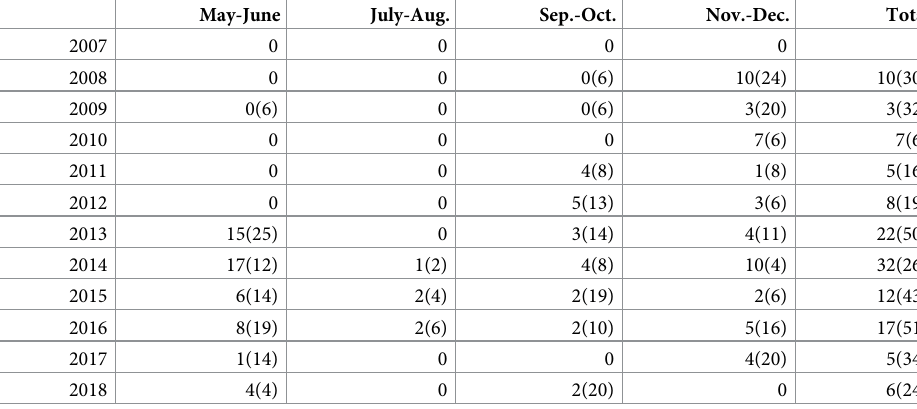
Table 2. The numbers of deer hunted by nuisance